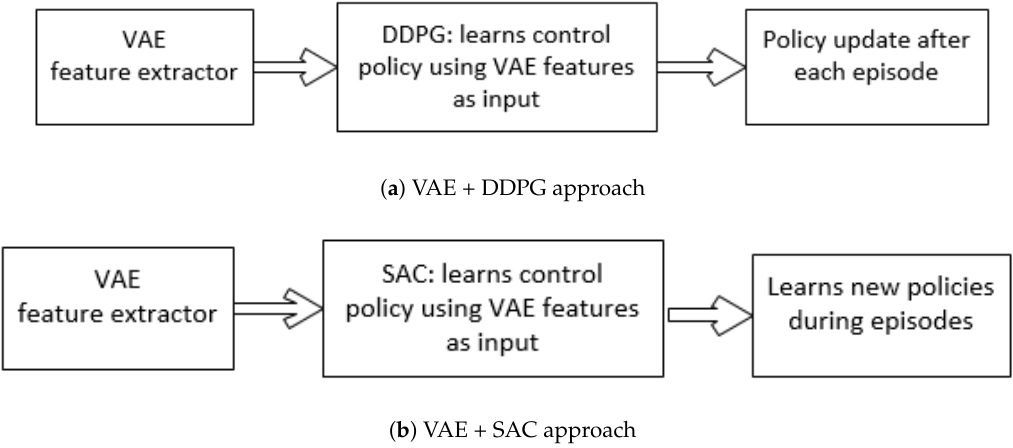
Figure 2. Block diagrams representing variational autoencoder (VAE) + deep deterministic policy gradient (DDPG) and VAE + soft actor-critic (SAC)